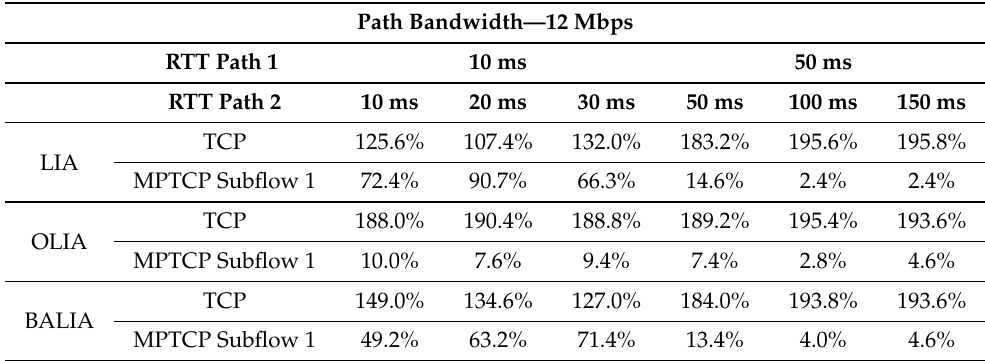
Table 2. Share of 12 Mbps bandwidth attained at Switch One-Disjoint